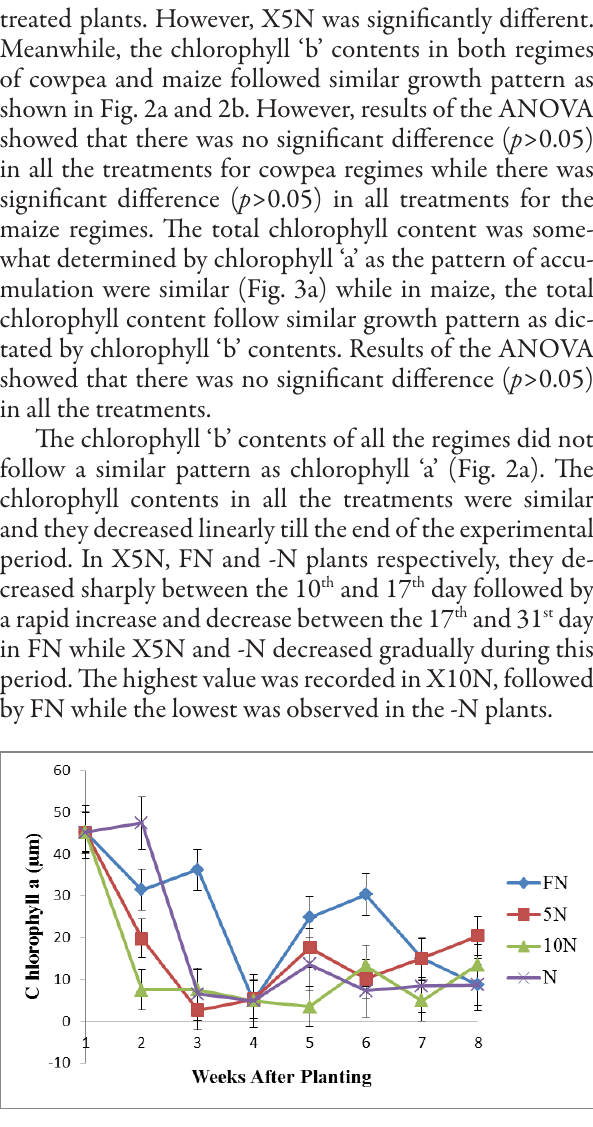
Fig. 1b. The effect of nitrogen nutritional stress on the chloro- phyll a accumulation of Zea mays measured at different periods